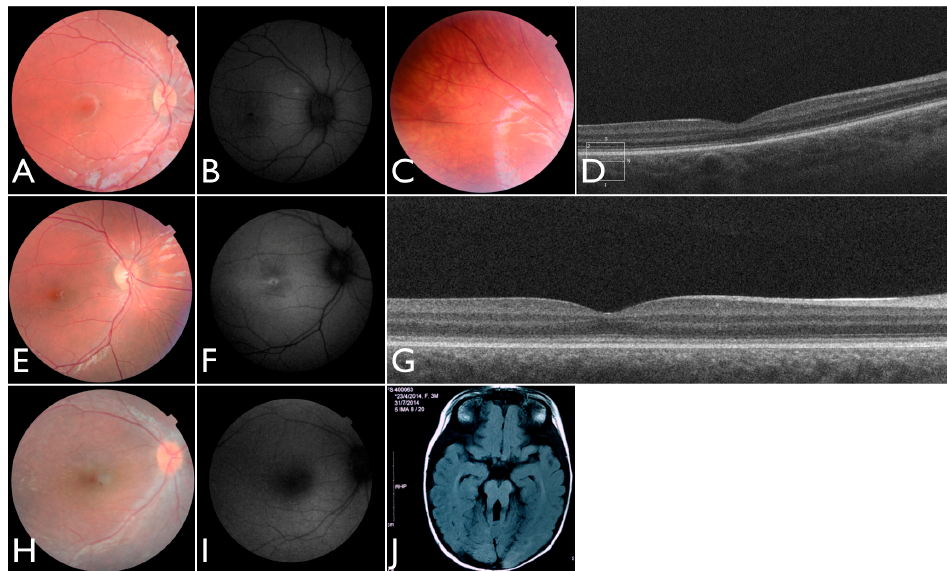
Figure 7. Images for four individuals solved by mutations in other retinal disease genes. ( A – C ) Fundus, autofluorescence and OCT images of FBP_three solved by mutations in CNGB3 . ( D – G ) Fundus and autofluorescence images of FBP_171 solved by mutations in CNGB3 . ( H – I ) Fundus image and autofluorescence of FBP_170 solved by mutations in ALMS1 . ( J ) Axial T1 MRI of FBP_327 solved by mutations in the AHI1 showing the molar tooth